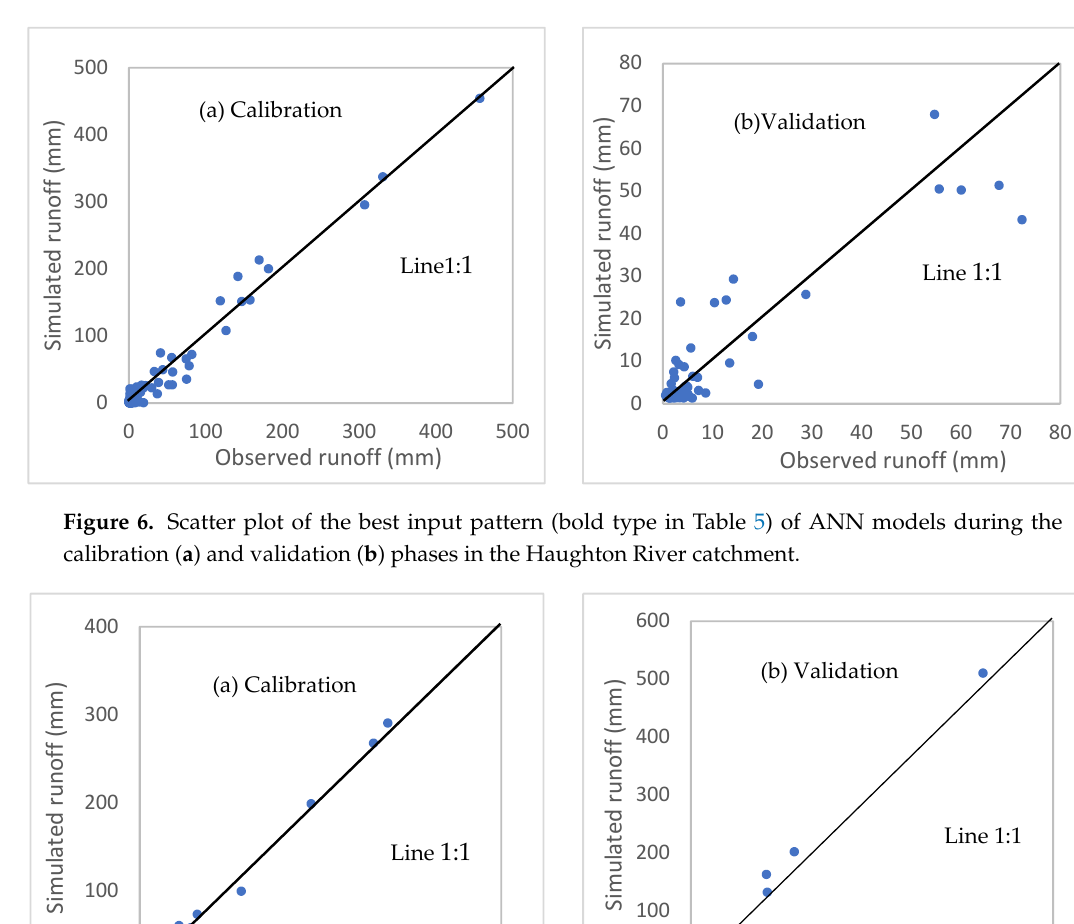
( c ) Figure 5. Comparison of average of performance indices (root mean squared error (RMSE), Nash– Sutcliffe model performance coefficient (NS), and coefficient of determination (R 2 )) for the ANN model with different input patterns in the validation period for Haughton River and Calliope River catchments ( a – c ). Comparing the calibration with the validation phase revealed that, in Calliope River, the performance indices values of the ANN models during the calibration phase were better than those during the validation phase, while in Haughton River this was reverse. This result based on the statistical parameters (Table 2) is understandable. For both the calibration and validation phases, scatter plots are presented for the best input patterns of ANN models (bold type in Tables 5 and 6) for the Haughton River catchment (Figure 6) and Calliope River catchment (Figure 7). Comparison